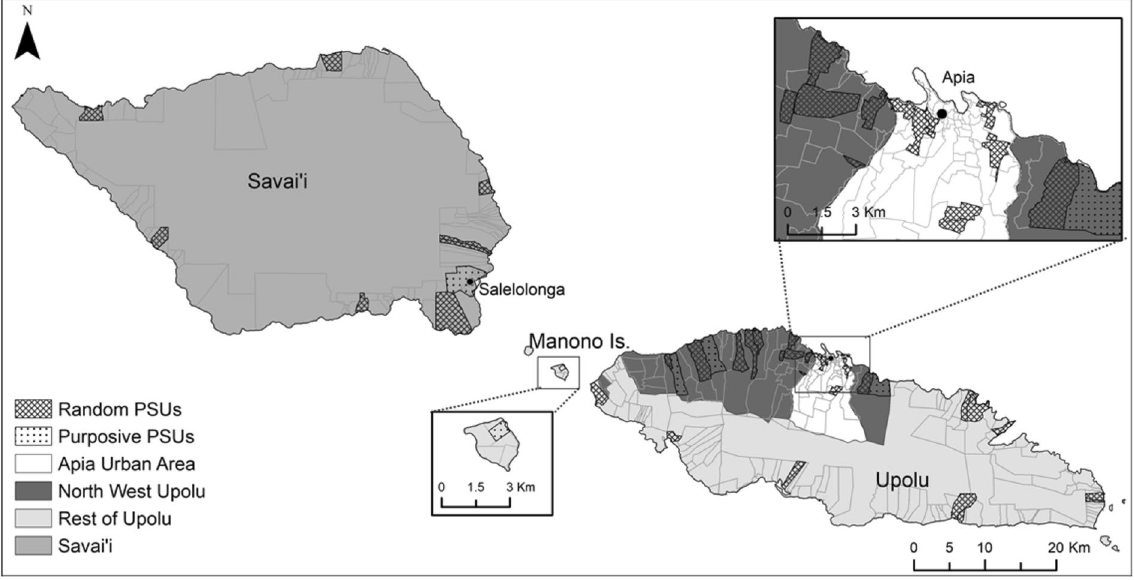
Figure 5. Location of random and purposive sampled primary sampling units in Samoa for 2018 and 2019 field surveys. Spatial data on country, island, region, and village boundaries in Samoa were obtained from the Pacific Data Hub (pacificdata.org) and DIVA-GIS (diva-gis.org). Geographic information systems (GIS) software (ArcGIS v10.4.1, Environmental Systems Research Institute, Redlands CA—www.esri.com) was used to